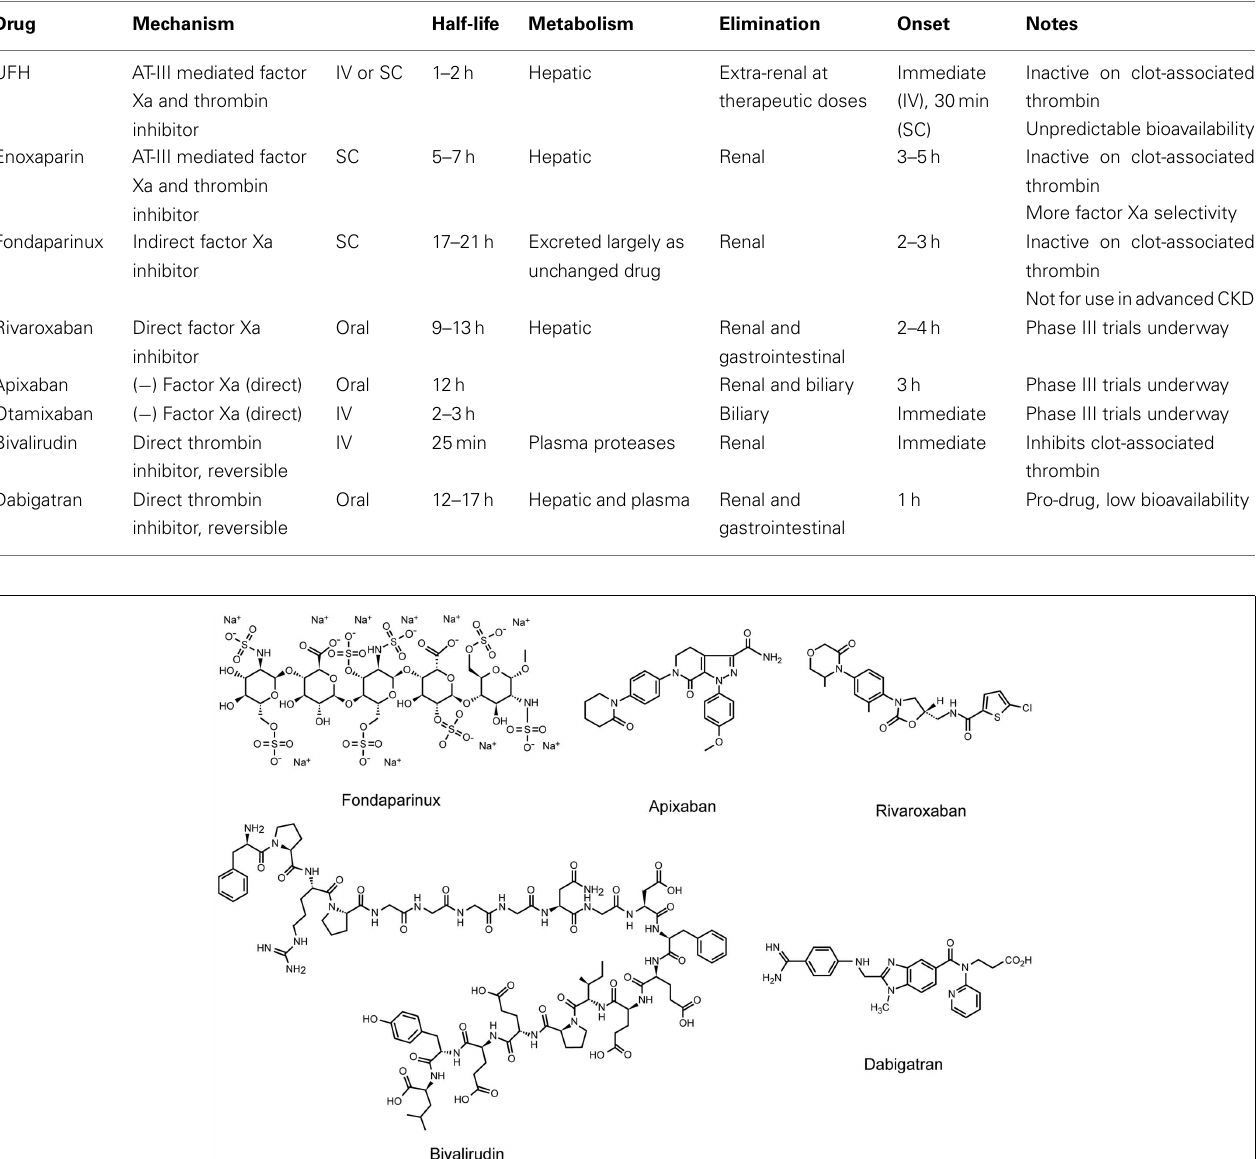
Table 3 | Pharmacodynamics and pharmacokinetics of anti-coagulants inACS.